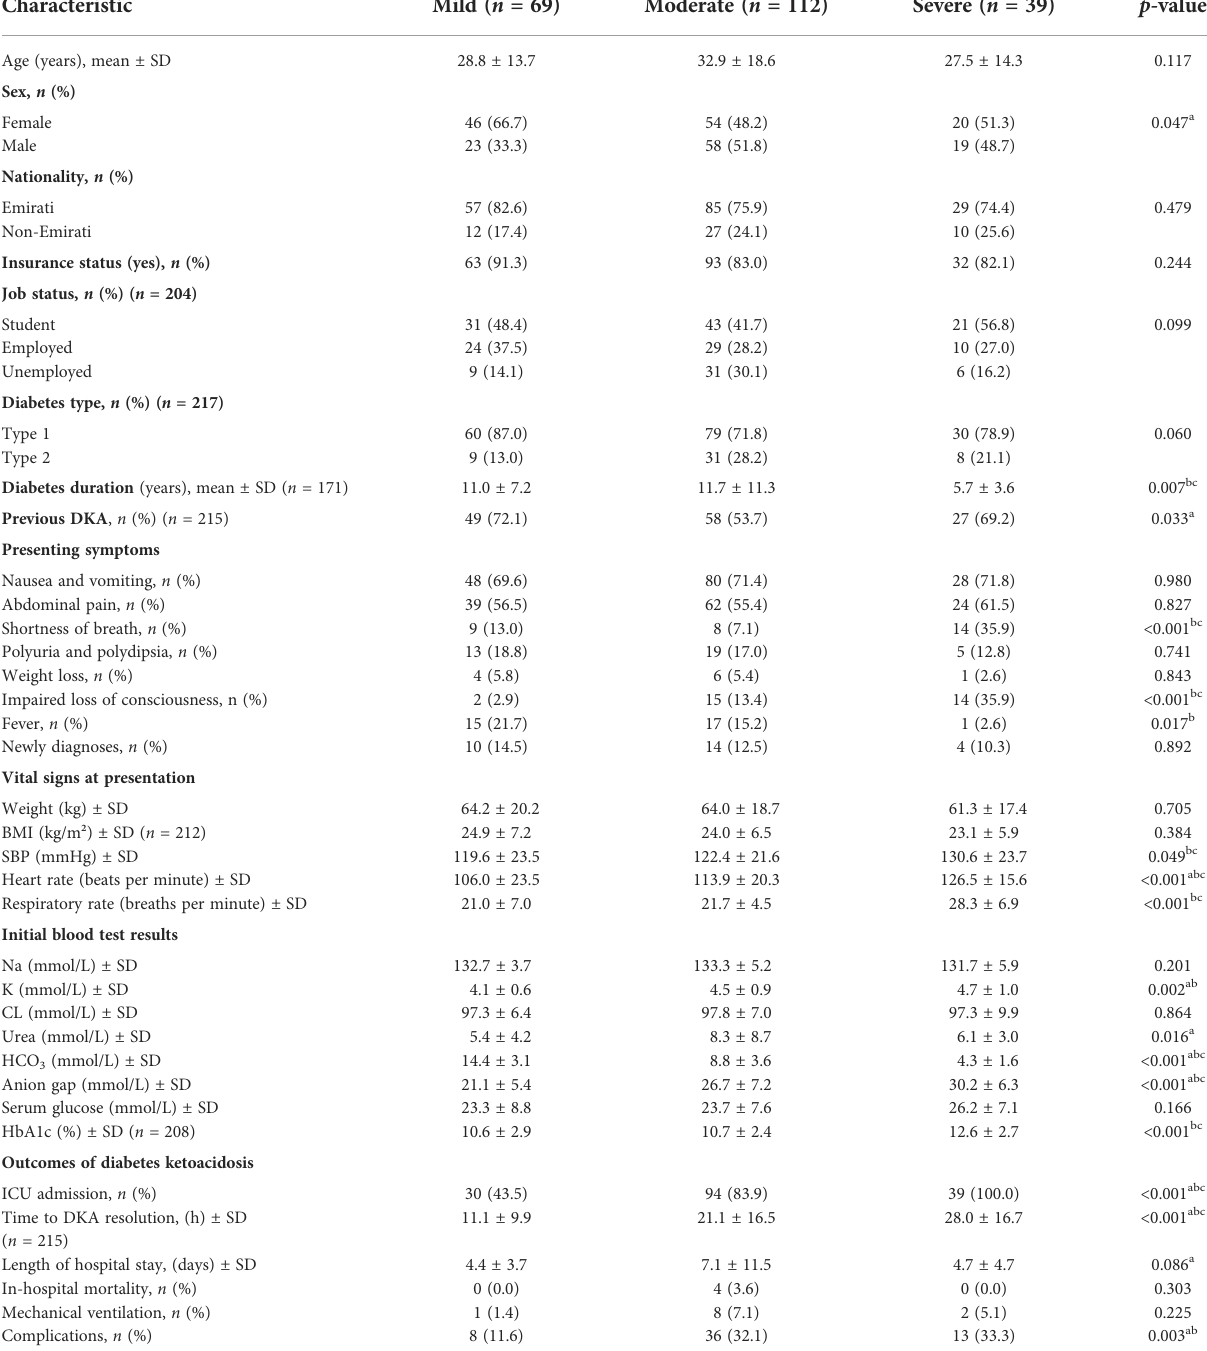
TABLE 5 Clinical features of patients with mild, moderate, and severe DKA.